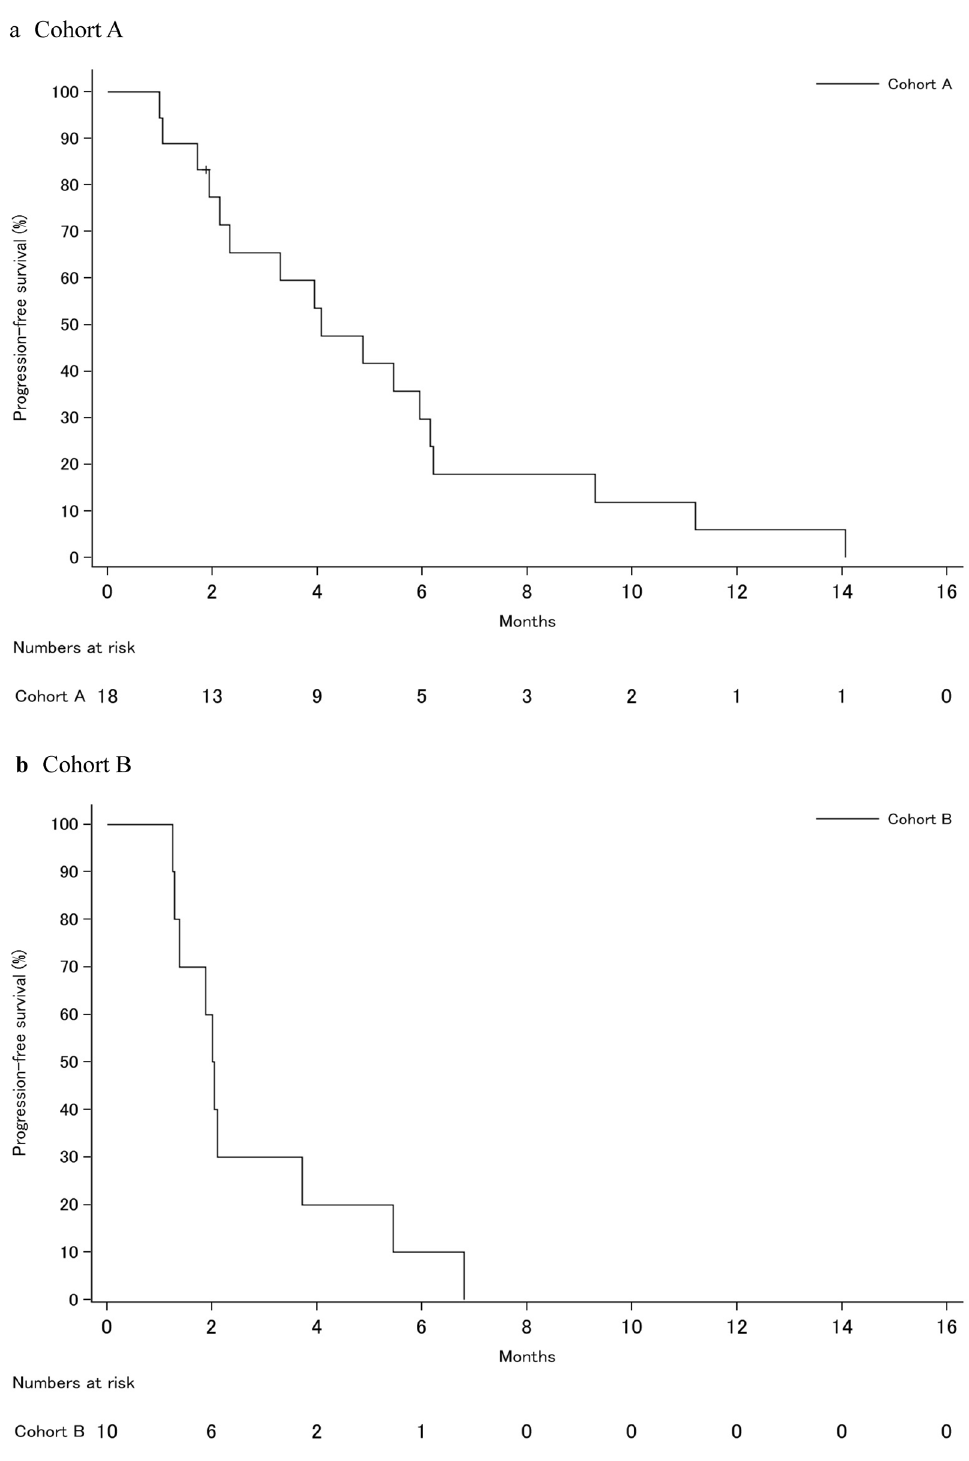
Figure 2. Kaplan–Meier curves of progression-free survival of the study cohort. ( a ) Cohort A, ( b ) Cohort